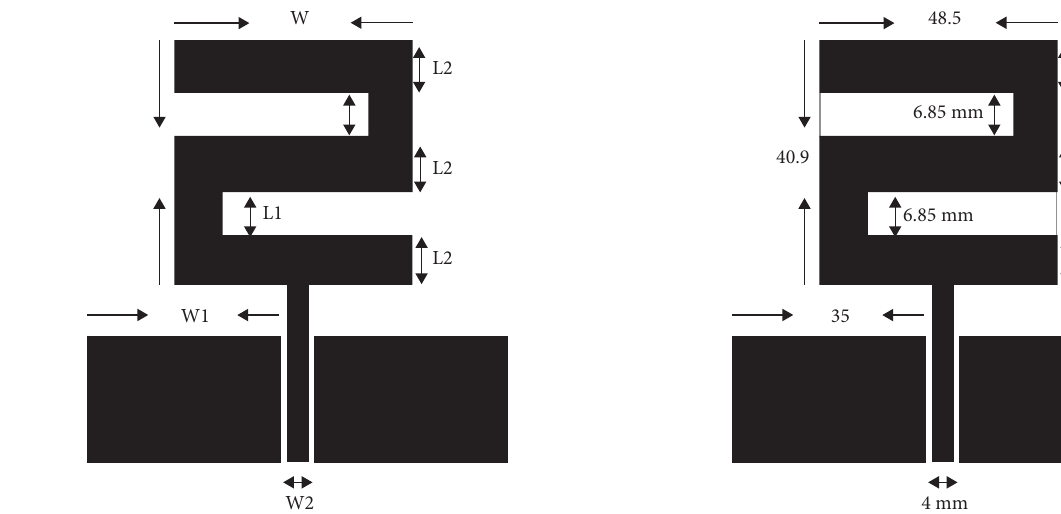
Figure 1: Configuration of Z-shaped microstrip patch antenna. Figure 2: CPW monopole element design .